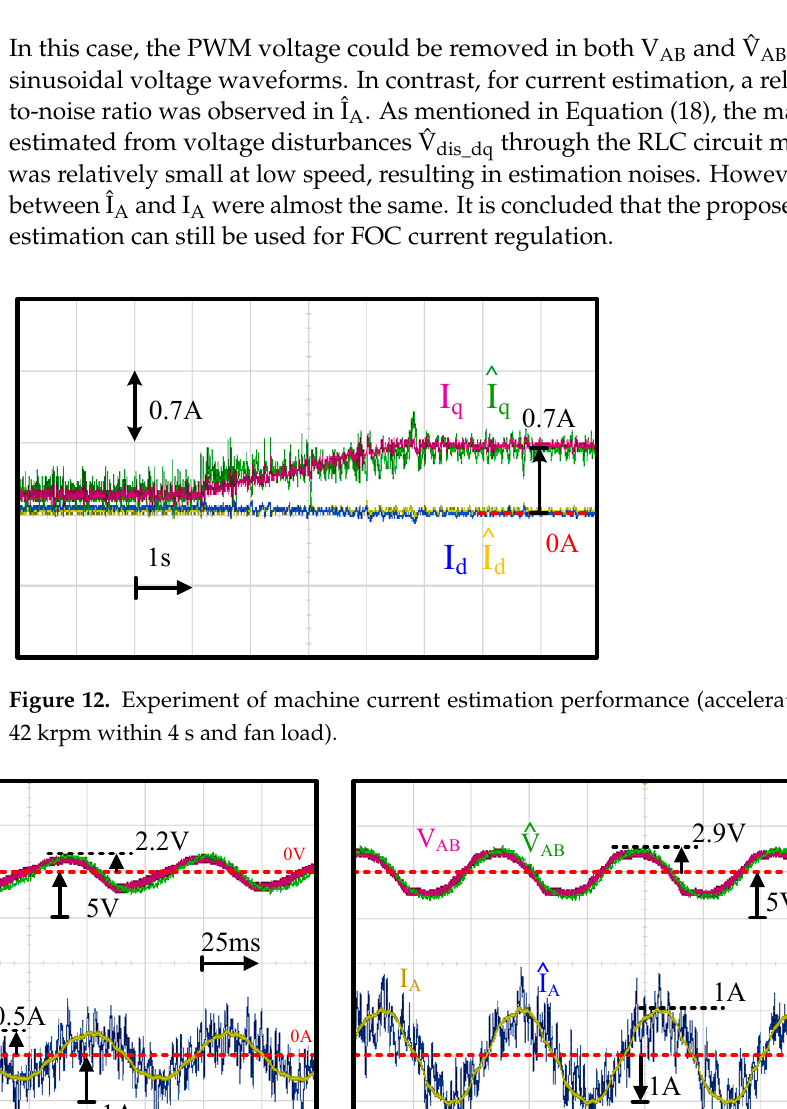
( b ) Figure 14. Sensitivity analysis of proposed observer-based current estimation under ( a ) filter capacitor error and ( b ) inductance error (6 krpm to 42 krpm and fan load). In contrast, in Figure 14b, the same 50% filter inductance error was included to evaluate the same I^ q estimation performance. In contrast to the capacitor parameter, the estimation error increased as the speed increased. At 6 krpm, the current estimation error was negligible. However, this error increased to 26.3% as the speed increased to 42 krpm. This result was the same as the simulation in Figure 5a. Nevertheless, the filter inductance parameter should be known as it is selected by the drive designer.